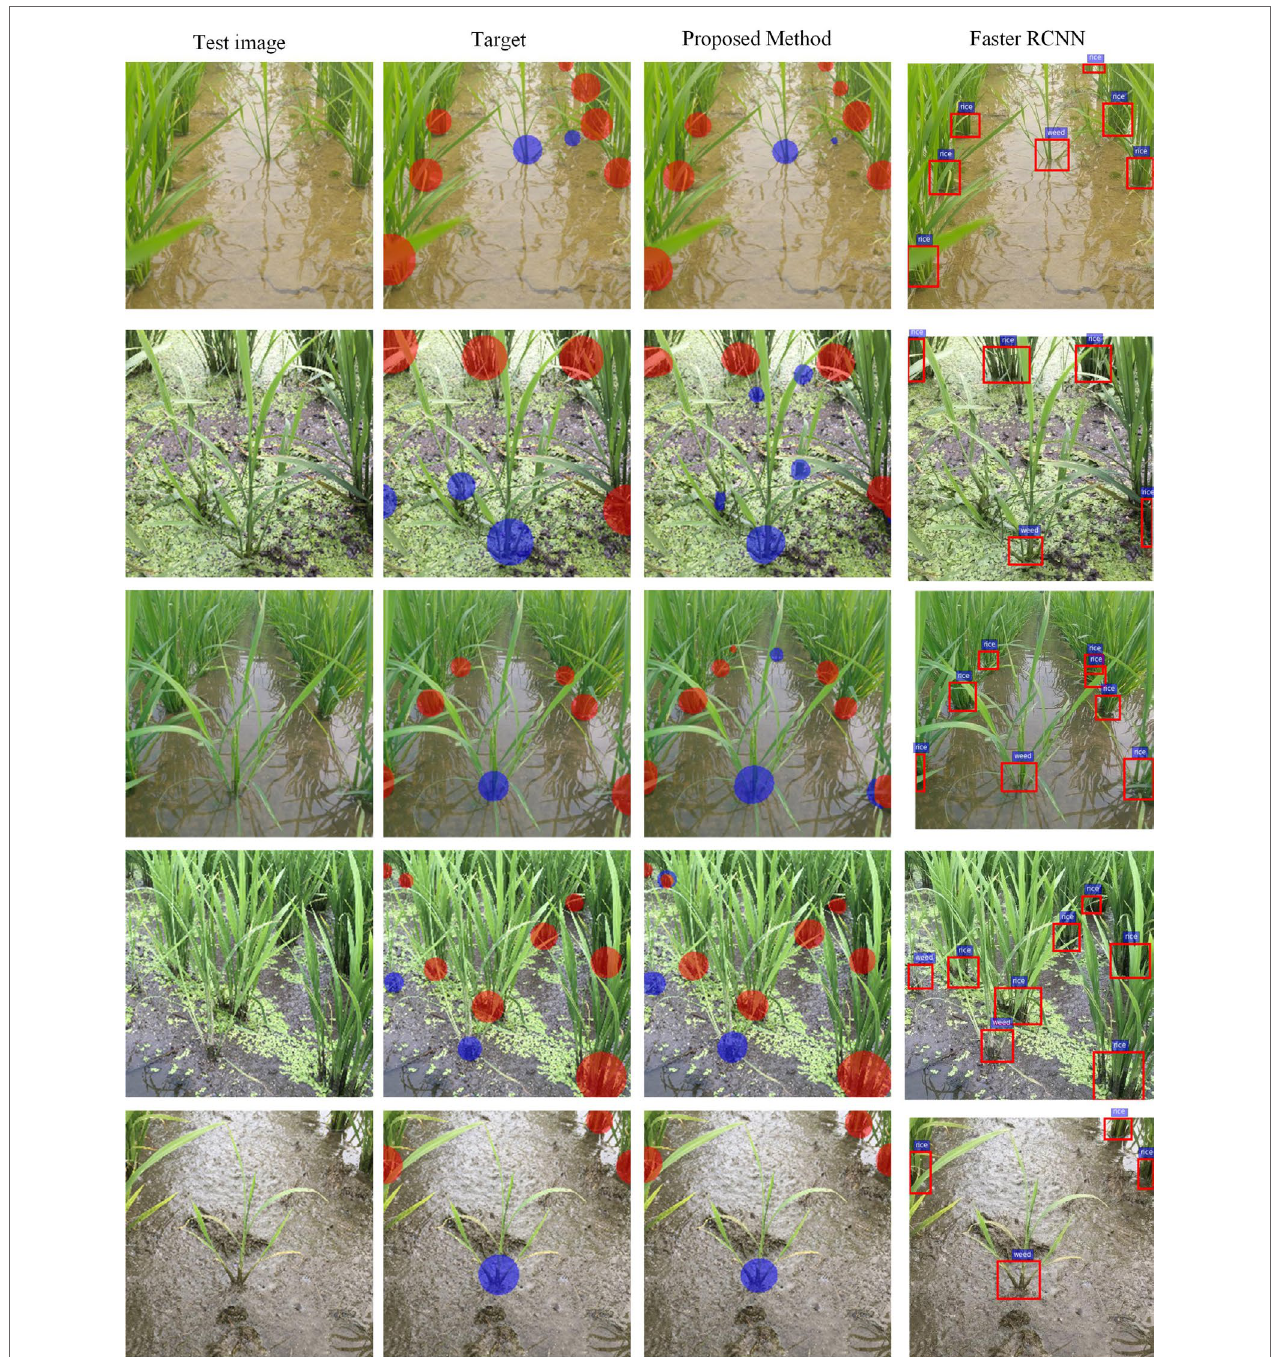
FIGURE 6 | Qualitative results of learning semantic graphics using the proposed convolutional encoder-decoder network on paddy–millet dataset. (Best viewed in color).